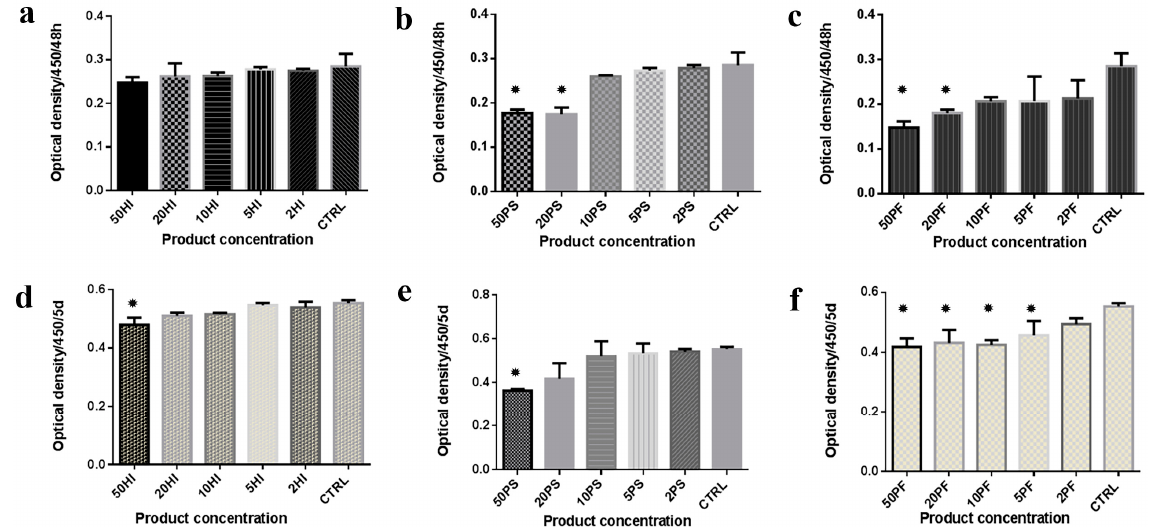
Figure 2. Proliferation after 48 h and 5 days of culture in different media. The whiskers correspond to the standard deviation. Results after 48 h for experimental media containing: ( a ) HI; ( b ) PS; ( c ) PF; results after 5 days for experimental media containing ( d ) HI; ( e ) PS; ( f ) PF; HI = HybenX; PS = Perisolv; PF = Perioflush; CTRL = Control. * = statistically different vs. controls.